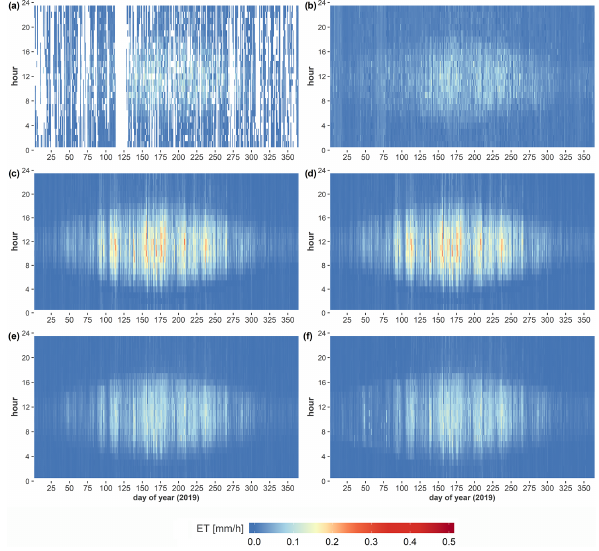
Figure A1. ET by day of the year and hours of the day for the TUCC site. Observed ET after cleaning (a) , observed ET gap- filled with MDS (b) , Penman–Monteith ET 0 (c) , predicted ET with SCOPE_ET 0 model (d) , predicted ET with SCOPE_DWD model (e) , and predicted ET with SCOPE_RS model (f)